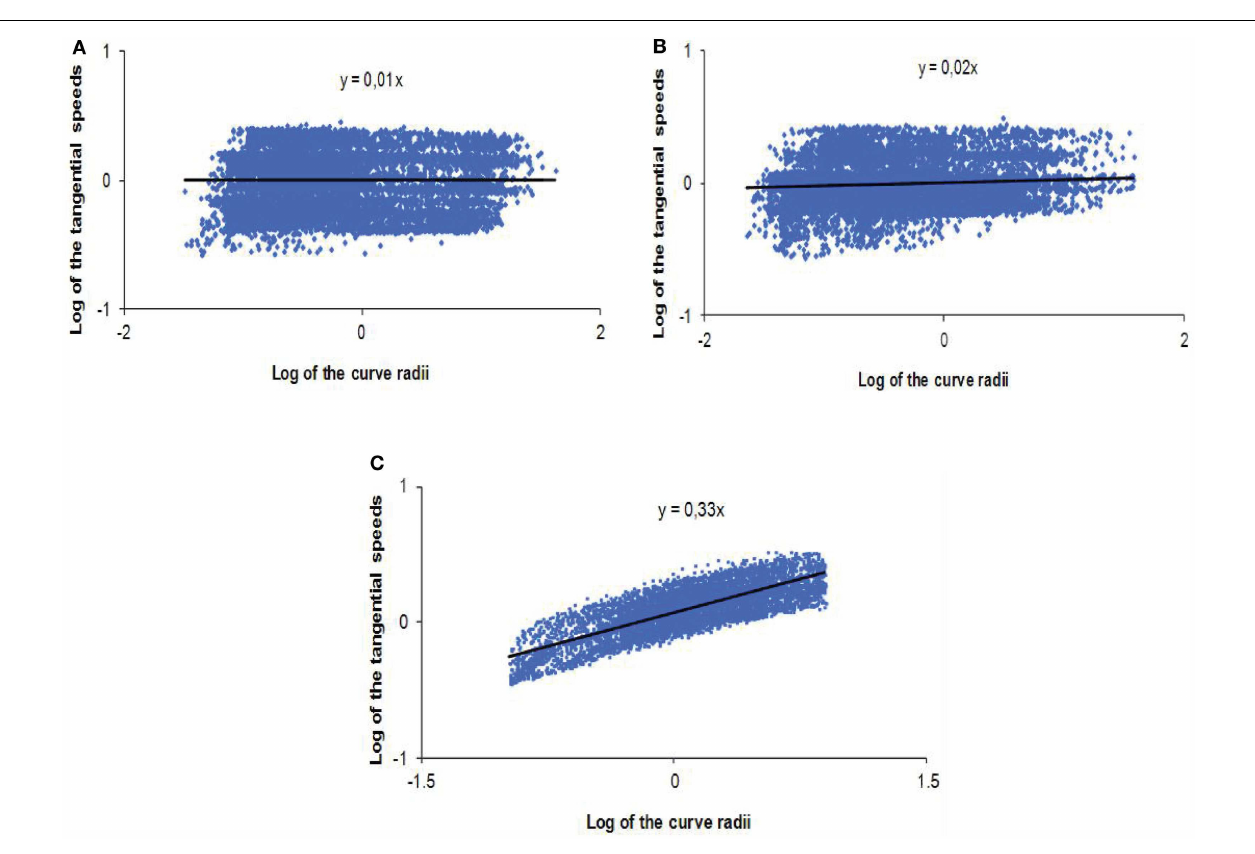
FIGURE 7 | Logarithmic and standardized representations of the relationship between curve radii and tangential velocities for the unit of